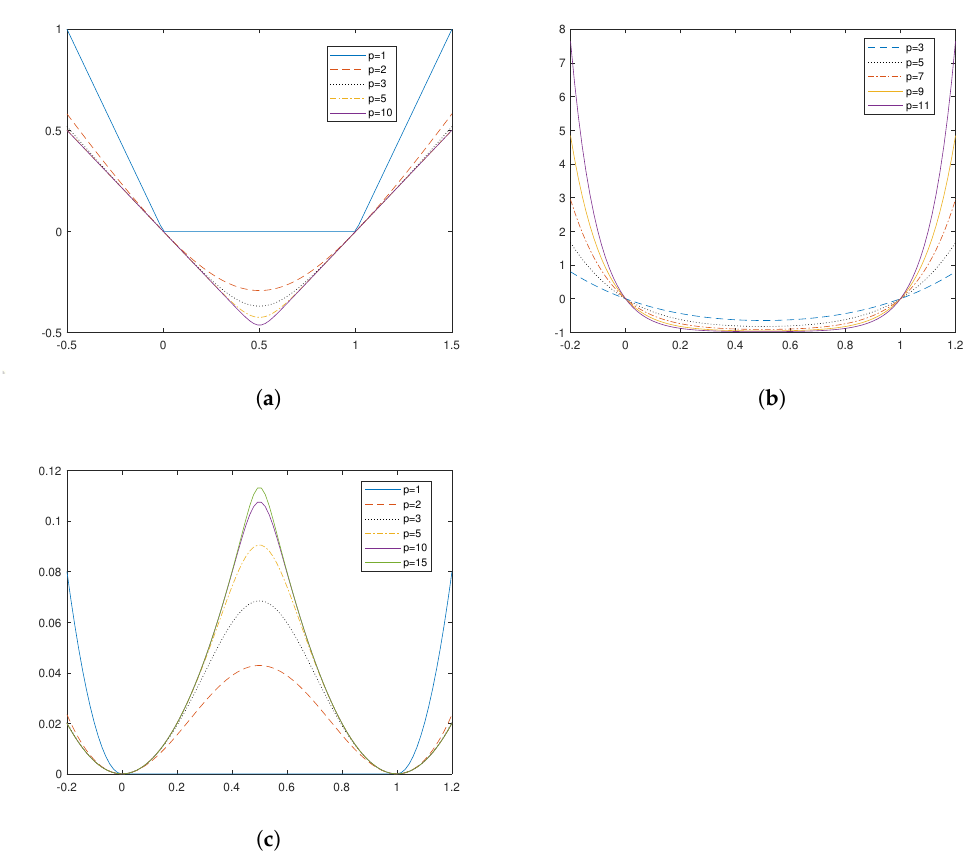
Figure 7. Graphs of τ p